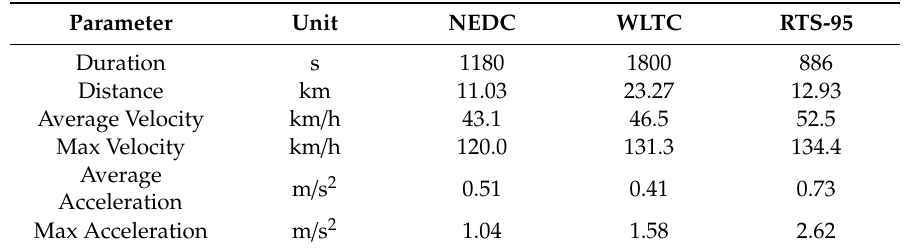
Table 6. Driving cycles data [20].